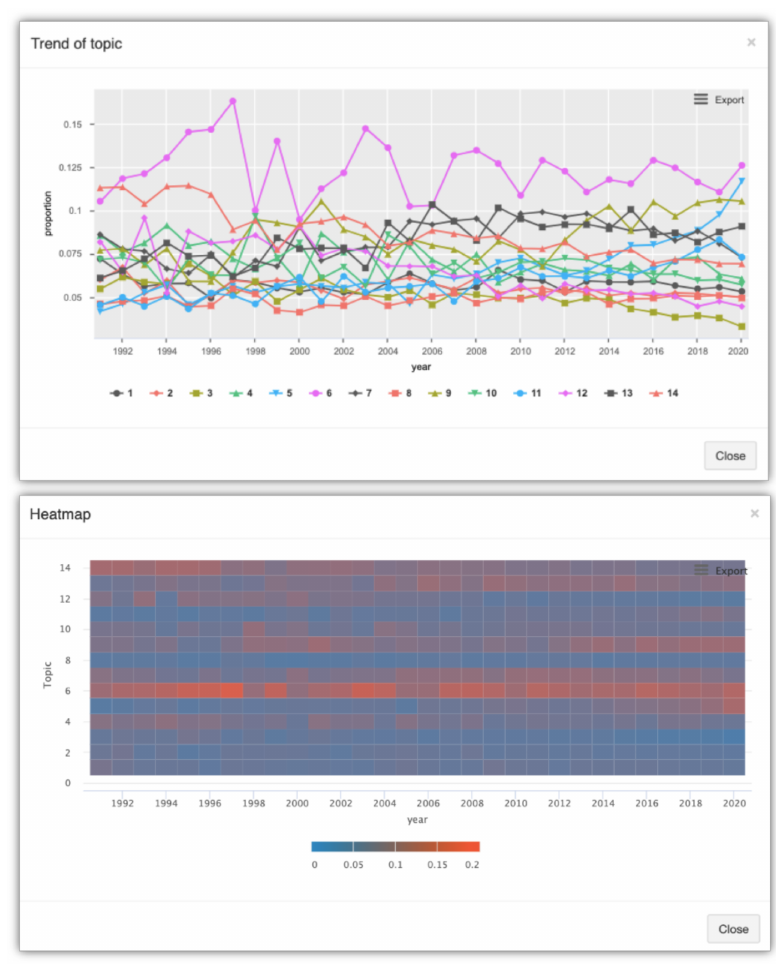
Figure 12. Graphical output of trend